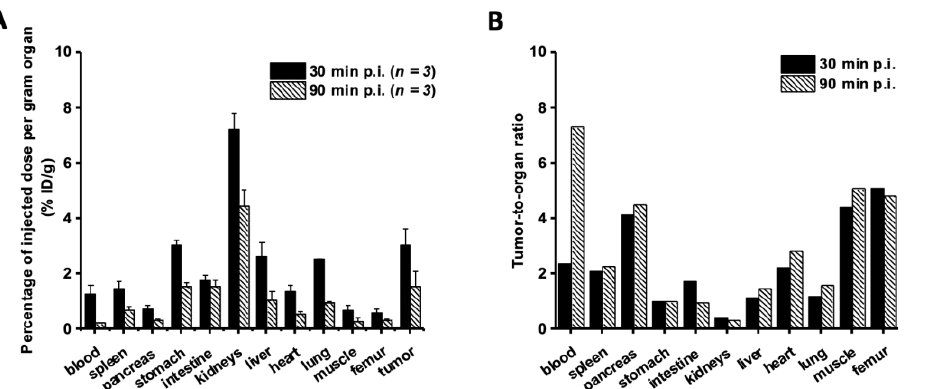
Figure 4. Ex vivo biodistribution of [ 68 Ga]Ga-DFO-c(RGDyK) in tumor-bearing (U-87 MG) Balb/c nude mice ( A ) and corresponding tumor-to-organ ratios ( B ) 30 and 90 min after r.o. injection.